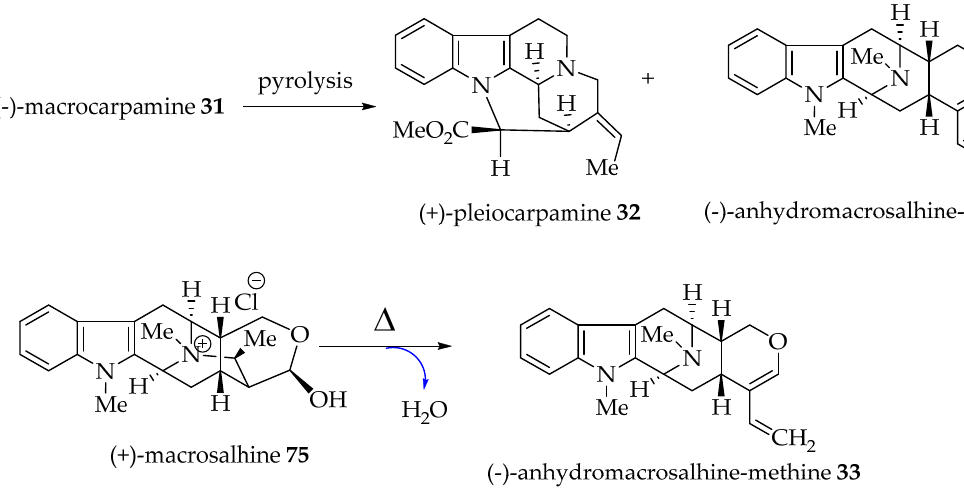
Figure 5. Possible alternative mechanism of bisindole formation via a Friedel–Crafts alkylation process for (+)-macralstonine 24 and (+)-lumutinine A 18, respectively, as representative examples.